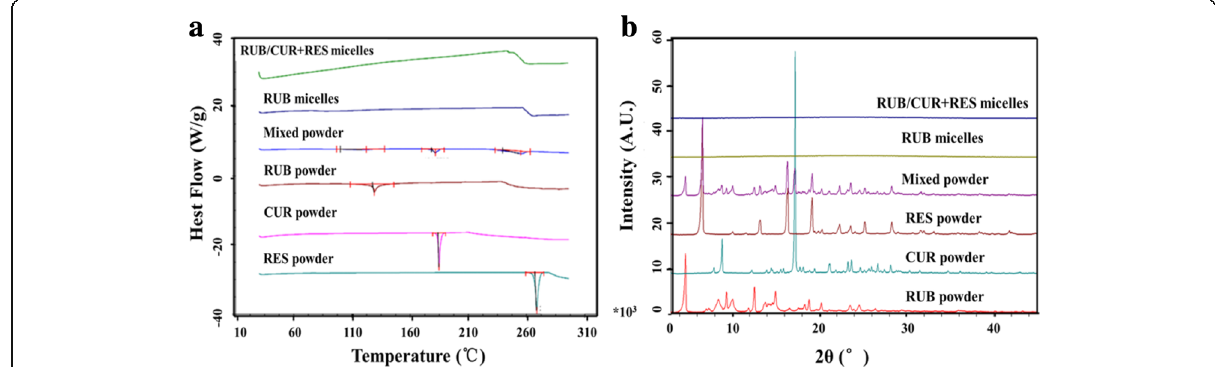
Fig. 4 Characterization of RUB/CUR + RES micelles. a X-ray diffraction of RUB/CUR + RES micelles. b Differential scanning calorimetry of RUB/CUR + RES